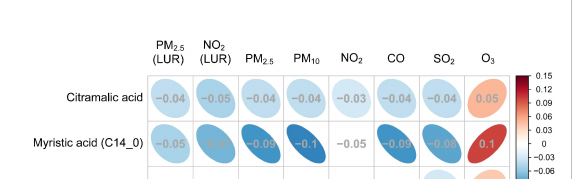
FIGURE 6 The association between GDM related metabolites and speci fi c air pollutants. The grey numbers are standardized regression coef fi cients that show the effect of one standard derivation (SD) pollutant change on the standardized log metabolite concentration. The red right-handed ellipses indicate positive relationships between metabolites and air pollutants, while the blue left-handed ellipses indicate negative relationships. Only the signi fi cant associations ( q -values < 0.05) between metabolites and pollutants are displayed by ellipses.